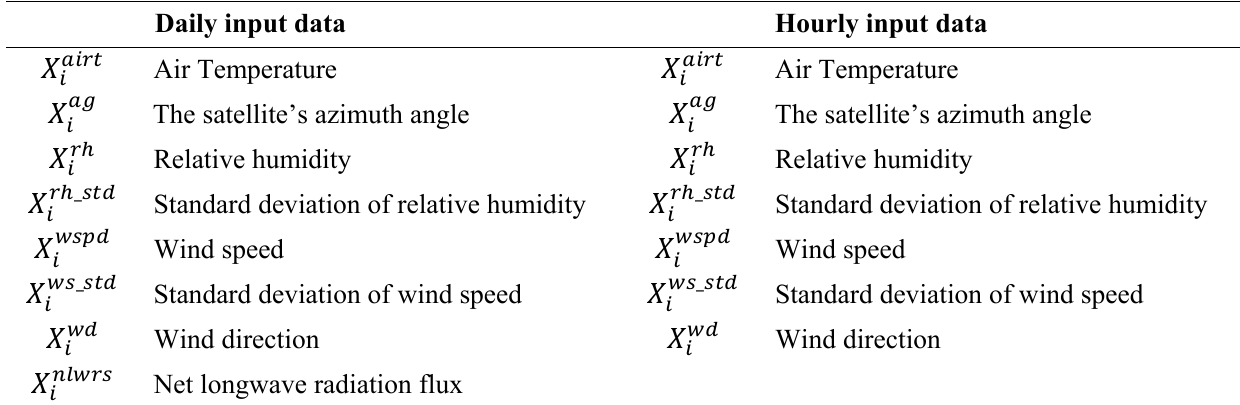
Table 1. List of predictor variables.